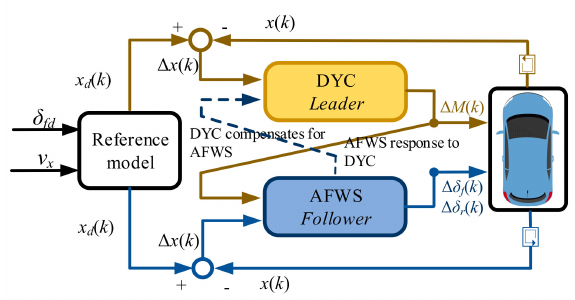
Figure 4. DYC and AFWS Stackelberg game control